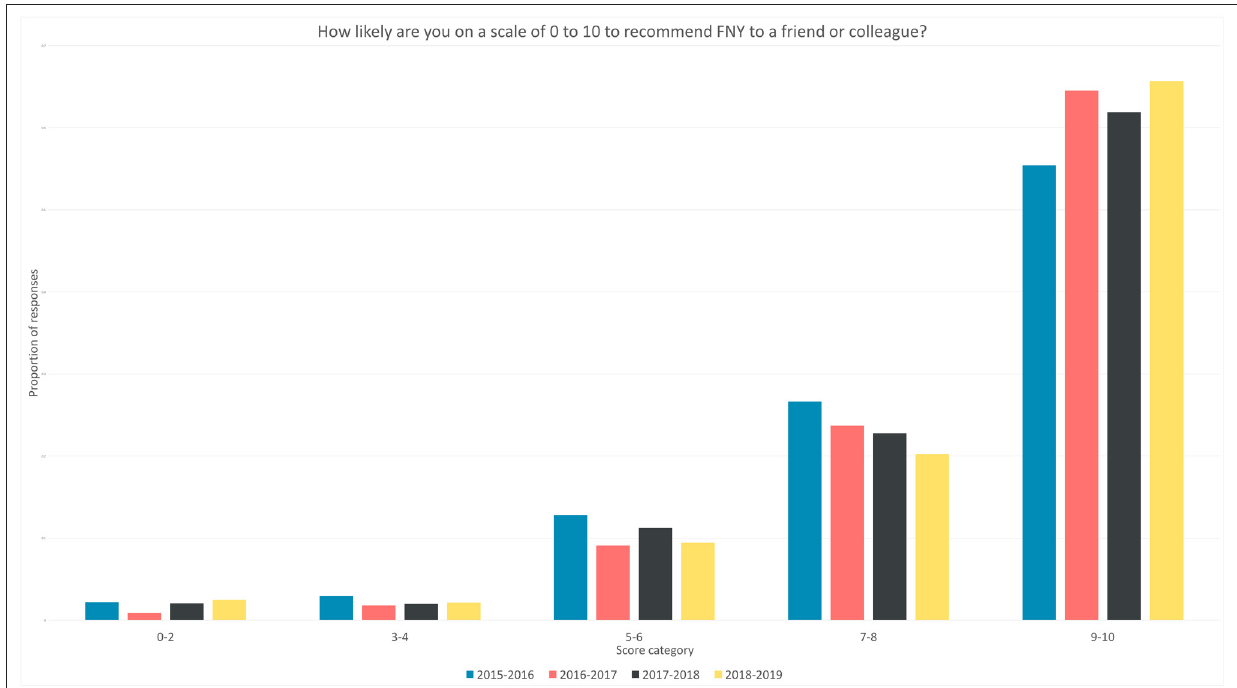
Figure 3 Proportion of responses to the survey question “How likely are you to recommend Flu Near You to a friend or colleague?” by influenza season. FNY: Flu Near